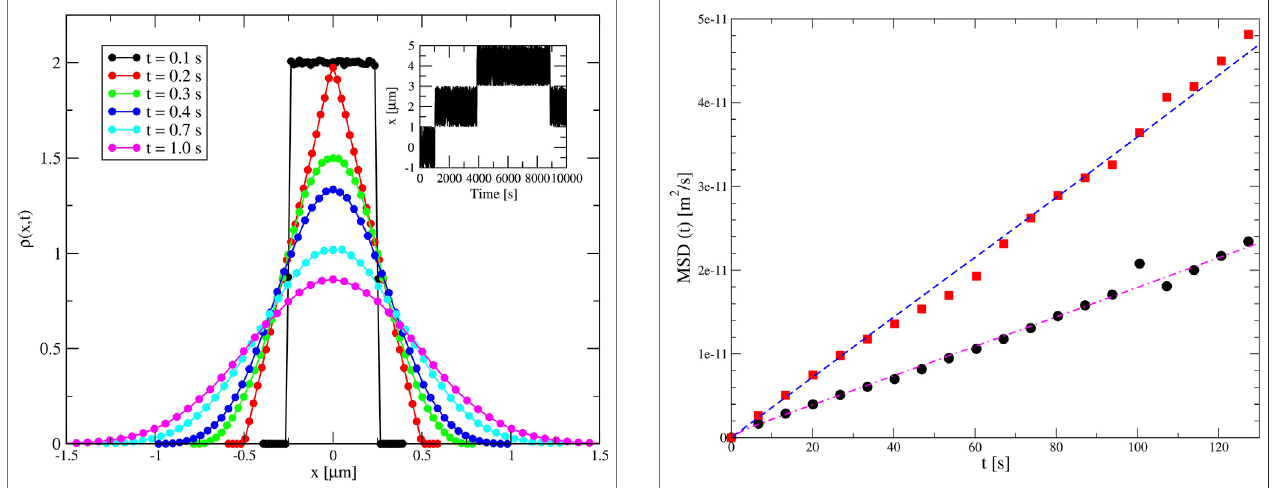
FIGURE 2 | (Color online) ρ ( x , t ) at different times for the random walker simulation. For t (cid:2) 0 . 1 s the step distribution is recovered, whereas the probability evolves to a Gaussian after a few steps. Inset: Representative trajectory obtained from the simulation, showing the caging effect and a hopping effect.